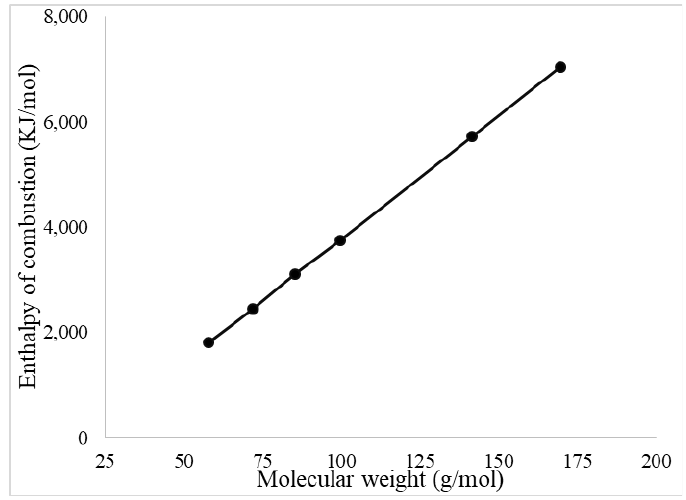
Processes 2022 , 10 , x FOR PEER REVIEW Figure 14. The effect of molecular weight of ketones on enthalpy of combustion . Figure 14. The effect of molecular weight of ketones on enthalpy of combustion.